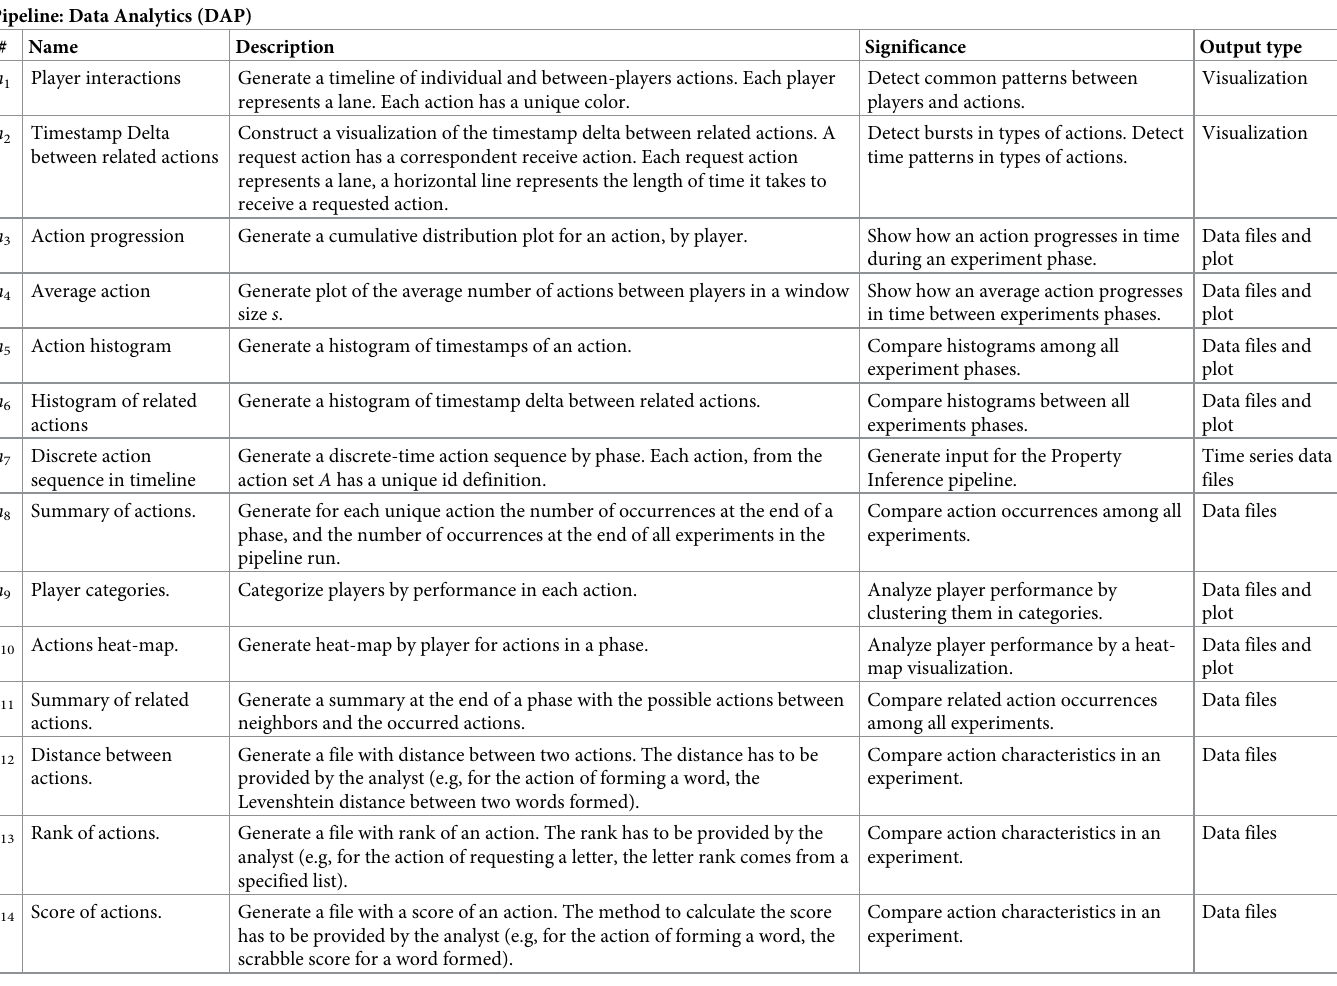
Table 10. Listing of types of functions as microservices for the (2) Data Analytics Pipeline (DAP). Pipeline: Data Analytics (DAP)